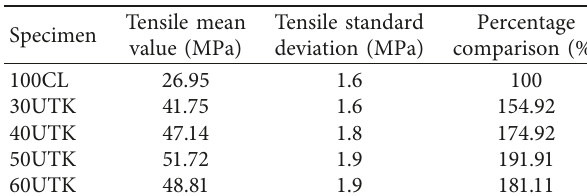
Table 2: Detail values for tensile